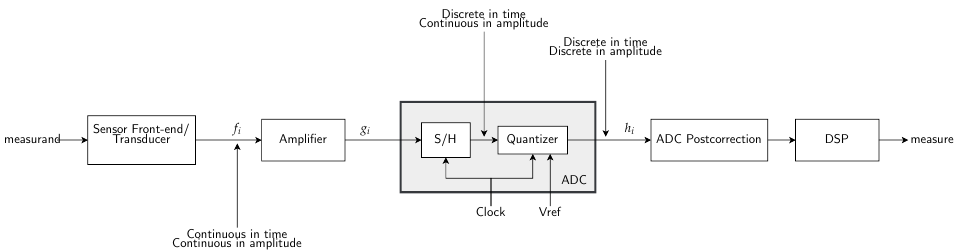
Figure 3. Schematic of the typical units that compose a sensor (from left to right ): transducer, amplifier, analog-to-digital converter (ADC), ADC postcorrection, and digital signal processing (DSP) units. The measurement of a phenomenon (measurand) as simple as temperature by a sensor is in and of itself an inductive process involving many biases. The action of the physico-electrical process of the sensor (via the units it encompasses) generates an electrical signal proportional to the physical phenomenon being measured. We, actually, do not have access to the physical phenomenon itself but to a representation provided through a transfer function deduced mathematically and that is specific to the physico-electrical process of the sensor. The choice of this process constitutes a bias similar to the elaboration of the transfer function.